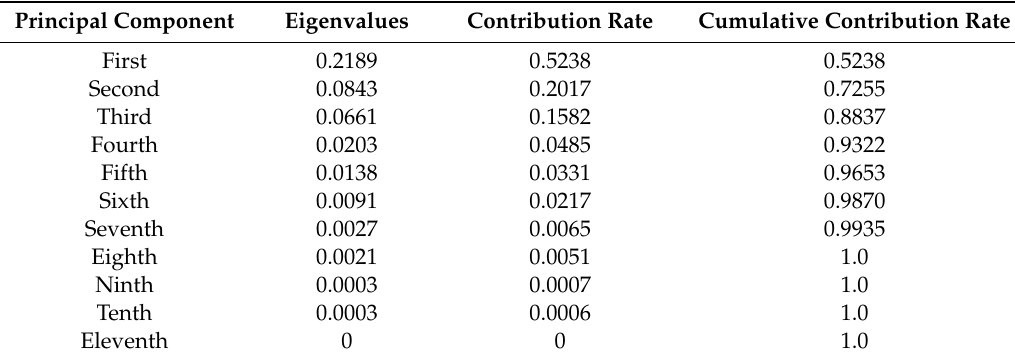
Figure 4. Training set and test set. Table 2. Calculation results of each principal component.